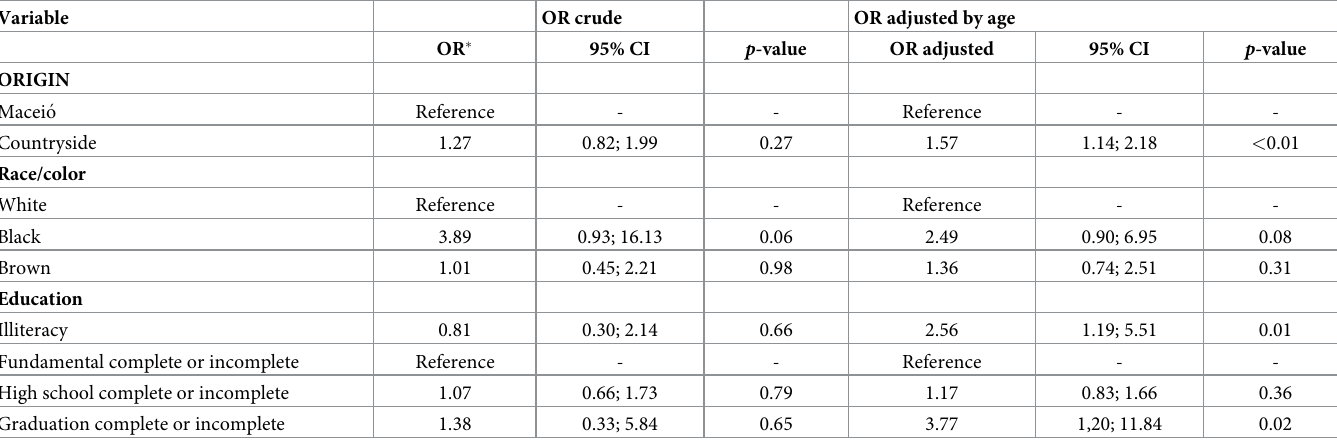
Table 2. Analysis of crude and age-adjusted odds ratio of sociodemographic variables of pregnant women with epilepsy.